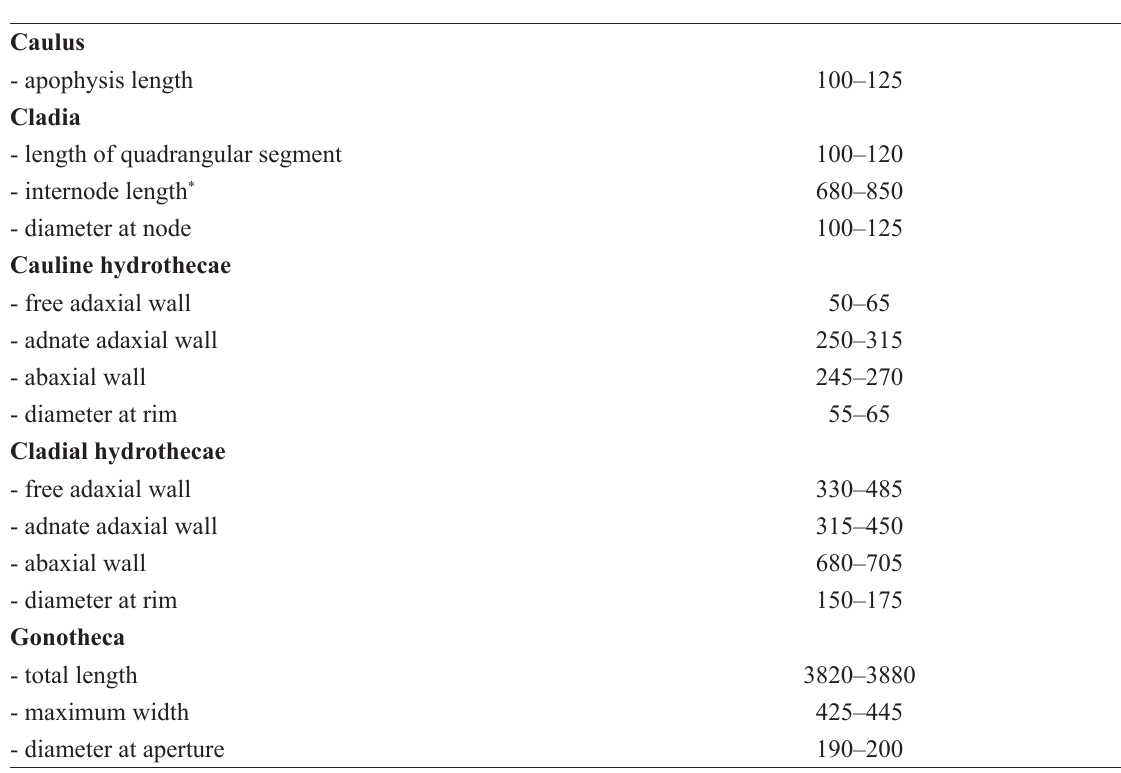
Table 7. Measurements of Hydrallmania clavaformis Galea, sp. nov., in µm. * When this comprises only two successive